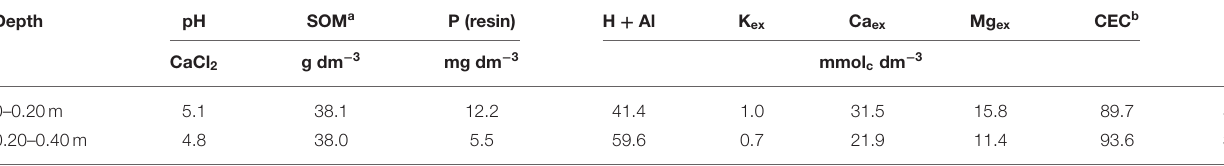
TABLE 2 | Soil chemical characteristics at two depths in the experimental area before the initiation of the experiment.